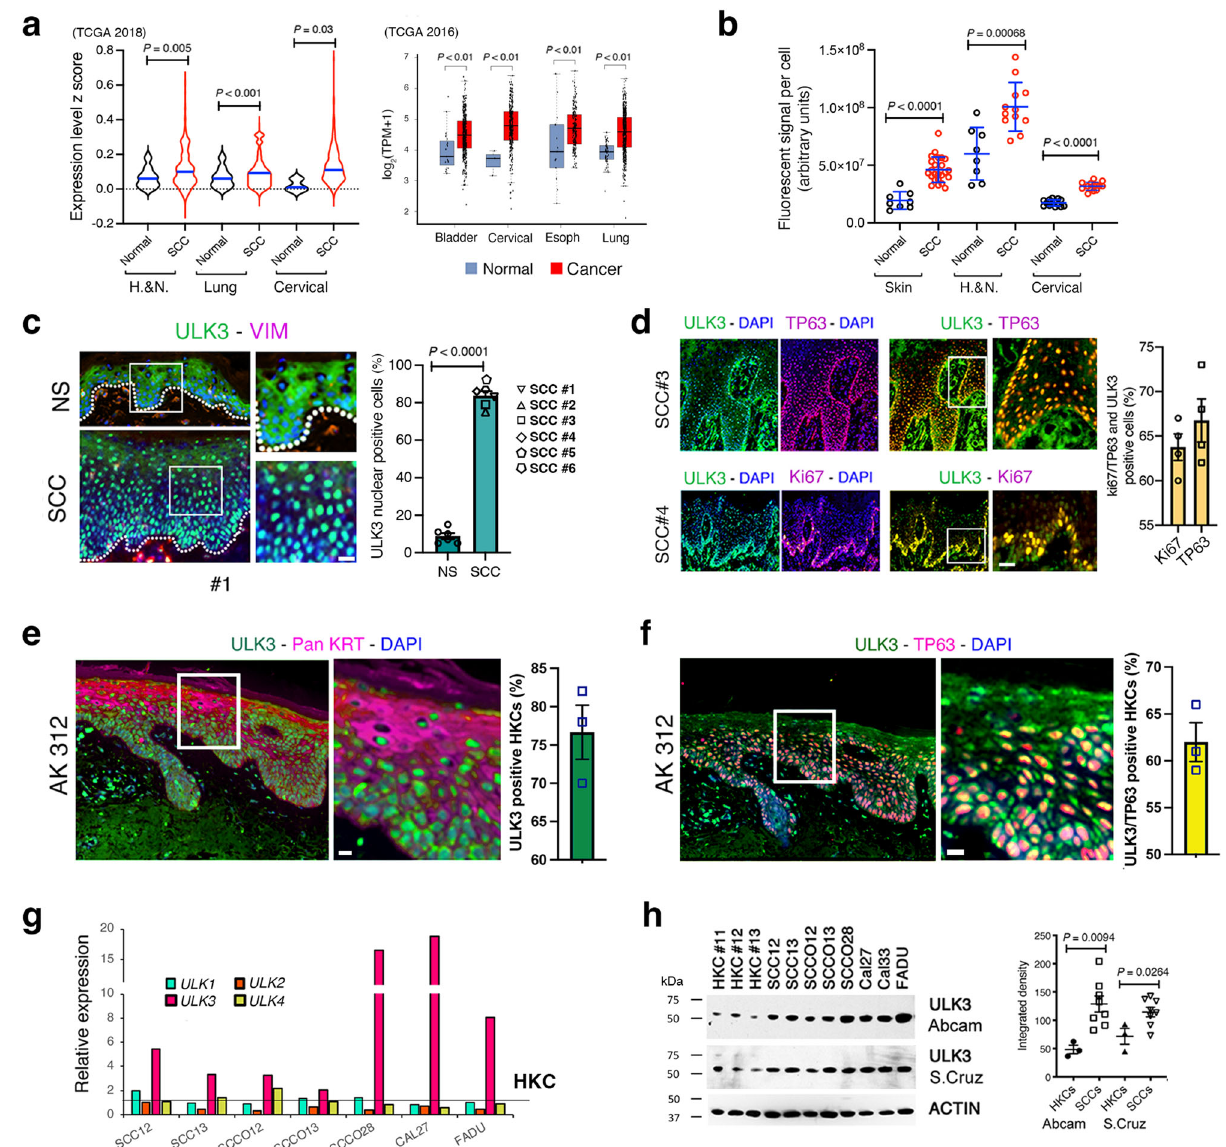
Fig. 1 | ULK3 is upregulated in clinical SCC samples and SCC cells. a ULK3 expression in TCGA pro fi les of Head/Neck (H&N), Lung, and Cervical Squamous CellCarcinomas(SCCs)versusmatchednormaltissuesupdatedto2018.Individual z-scores values, mean±SEM, P <0.01, two-tailed unpaired t-test. Box plots show ULK3 levels in the indicated SCCs versus normal tissues in TCGA datasets updated to 2016 as in ref. 2 . GEPIA-generated median, box (25 – 75%) and whiskers (5 – 95%), log(transcript per million+1), value cutoff P <0.01. b Quanti fi cation of Skin, H&N and Cervical SCCs tissue arrays ULK3 immunostaining with unmatched (Skin and H&N) or matched (Cervical) non-affected tissues. Skin: n (Normal=8, SCC=24); H&N: n (Normal=8, SCC=26); Cervical: n (Normal=14, SCC=14), mean±SEM, P <0.001, two-tailed unpaired t -test. c ULK3 (green) and VIMENTIN (magenta) immuno fl uorescence and quanti fi cation of nuclear ULK3 in normal skin (NS) and skin SCC. Representative low and high magni fi cations, n (NSs/SCCs)=6, mean± SEM, P <0.0001, two-tailed unpaired t-test. Scale bar 10 µ m. ULK3 immuno- fl uorescence of additional NSs/SCCs is in Supplementary Fig. 1a. d ULK3 (green) and Ki67 (magenta) or TP63 (magenta) immunofuorescence of skin SCCs (SCC#3 and SCC#4). Representative low and high magni fi cations with quanti fi cation